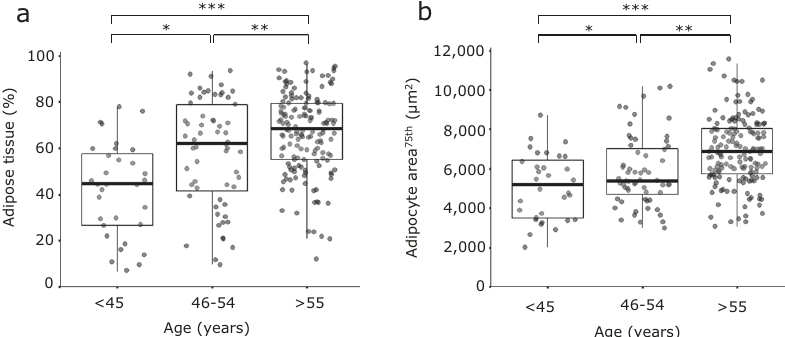
Fig. 3 Older DCIS patients have a higher percentage of breast adipose tissue and larger adipocyte size. a A higher percentage of mammary adipose tissue in one representative slide per DCIS patient is signi fi cantly associated with older age in n = 249 (unique) DCIS patients. * P = 0.002, ** P = 0.028, *** P < 0.001 (Mann-Whitney U Test), overall P < 0.001 (Kruskal-Wallis test). b Larger mammary adipocyte size is signi fi cantly associated with older age. * P = 0.049, ** P < 0.001, *** P < 0.001 (Student ’ s t -test), overall P < 0.001 (one-way